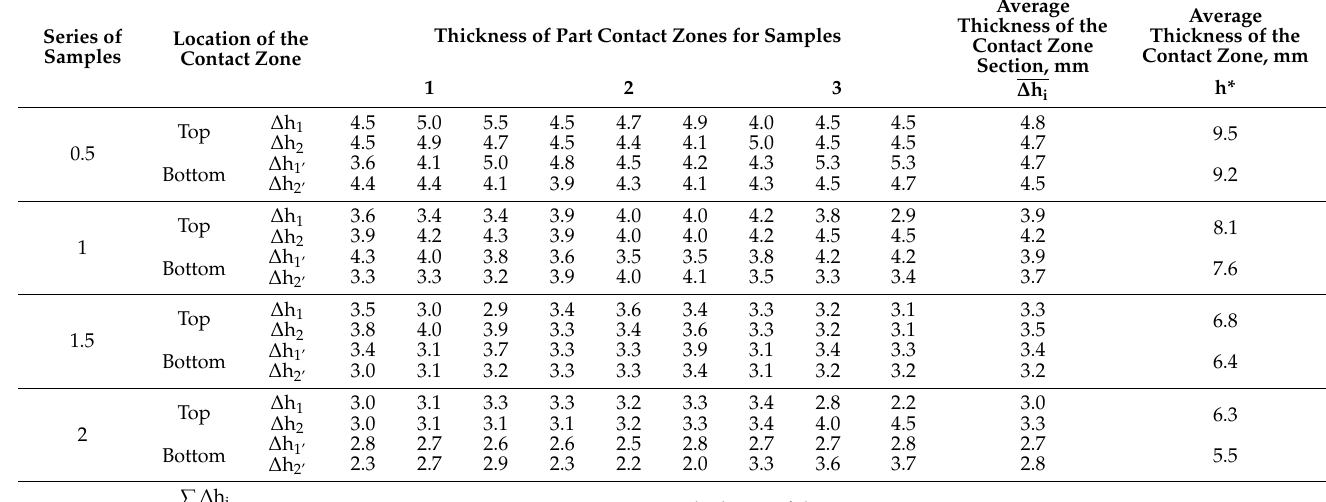
Table 6. Thickness of the contact zone,